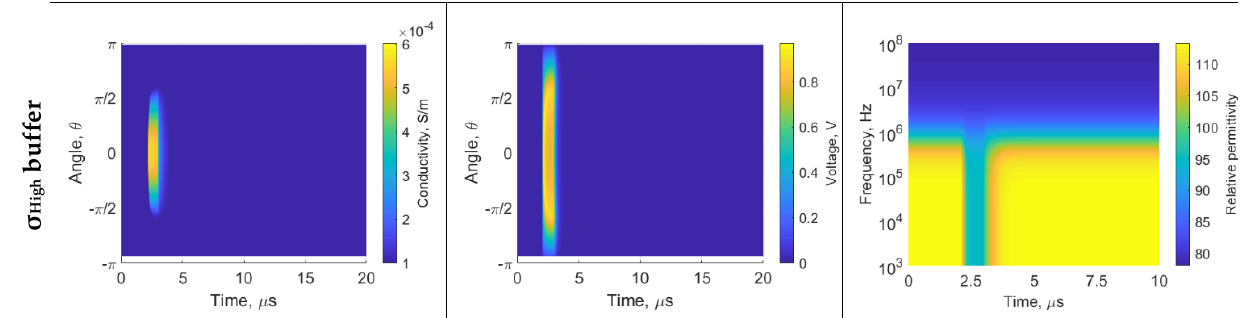
Figure 4. Results of 1 µs PEF: membrane conductivity, transmembrane voltage and solution equivalent relative permittivity. The axis description is used within Figure 3. The PEF starts at 2 µs, and ends at 3 µs. When using σ Low , the membrane conductivity changes are lower than 0.1%.